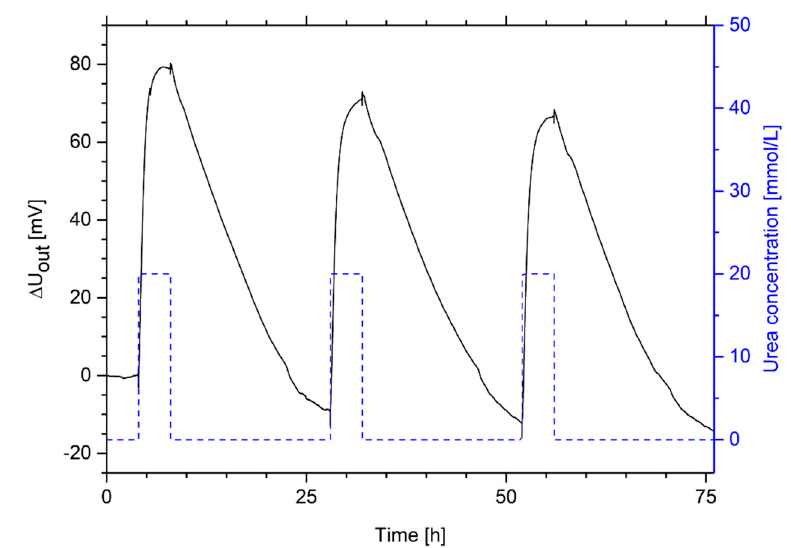
Figure 8. Repeatability of a hydrogel-based piezoresistive urea biosensor—Measurement of the output voltage Δ U out for cyclic changes of the urea concentration between 0 mmol/L and 20 mmol/L urea.